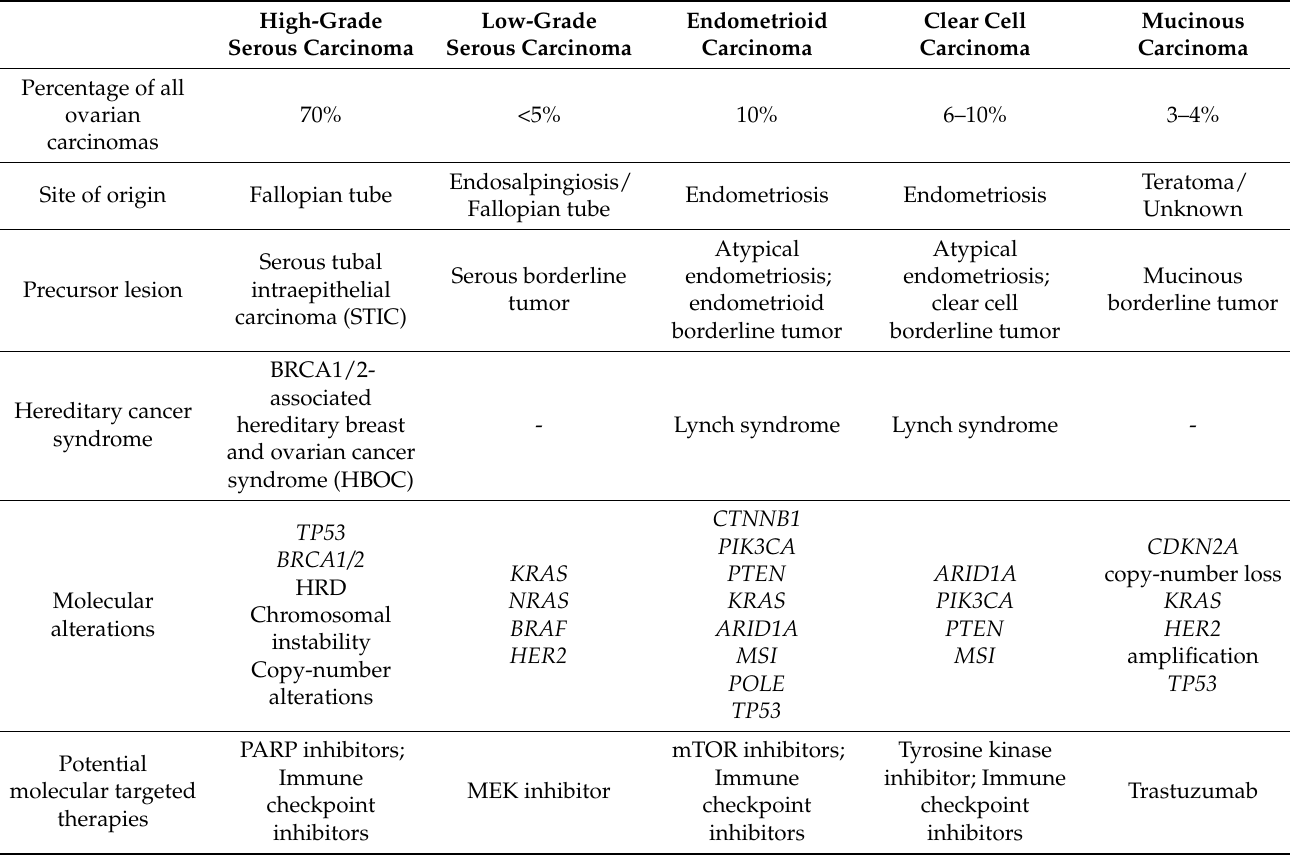
Table 1. Molecular and pathologic classification of ovarian